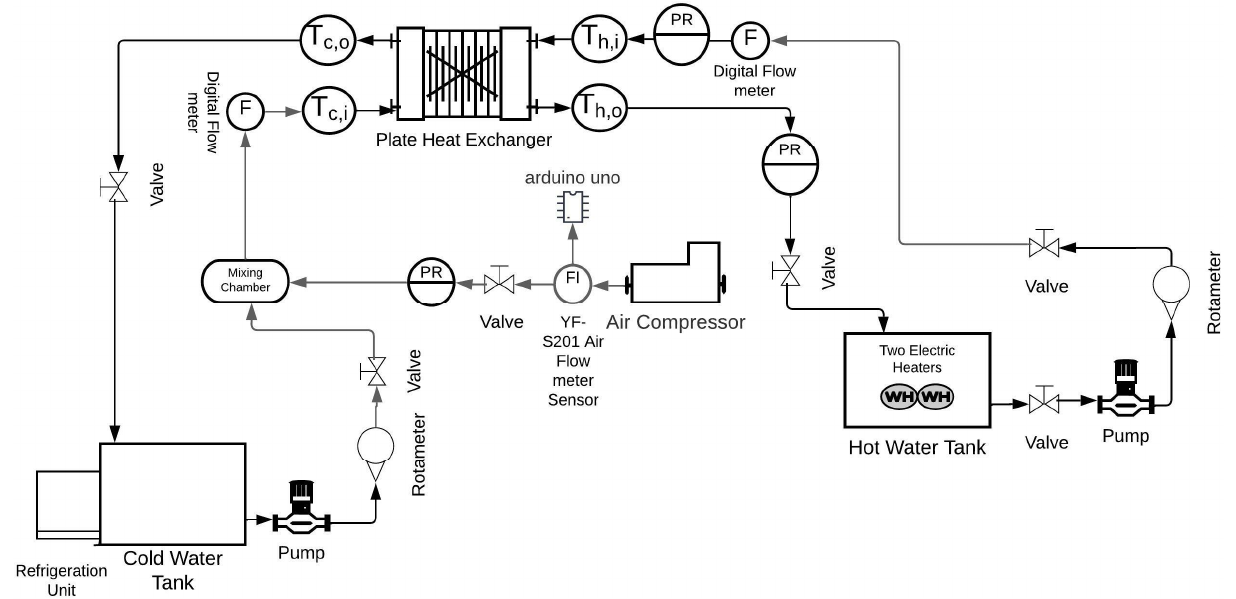
Figure 1. Schematic diagram for the experimental setup components of ABI into CWS.